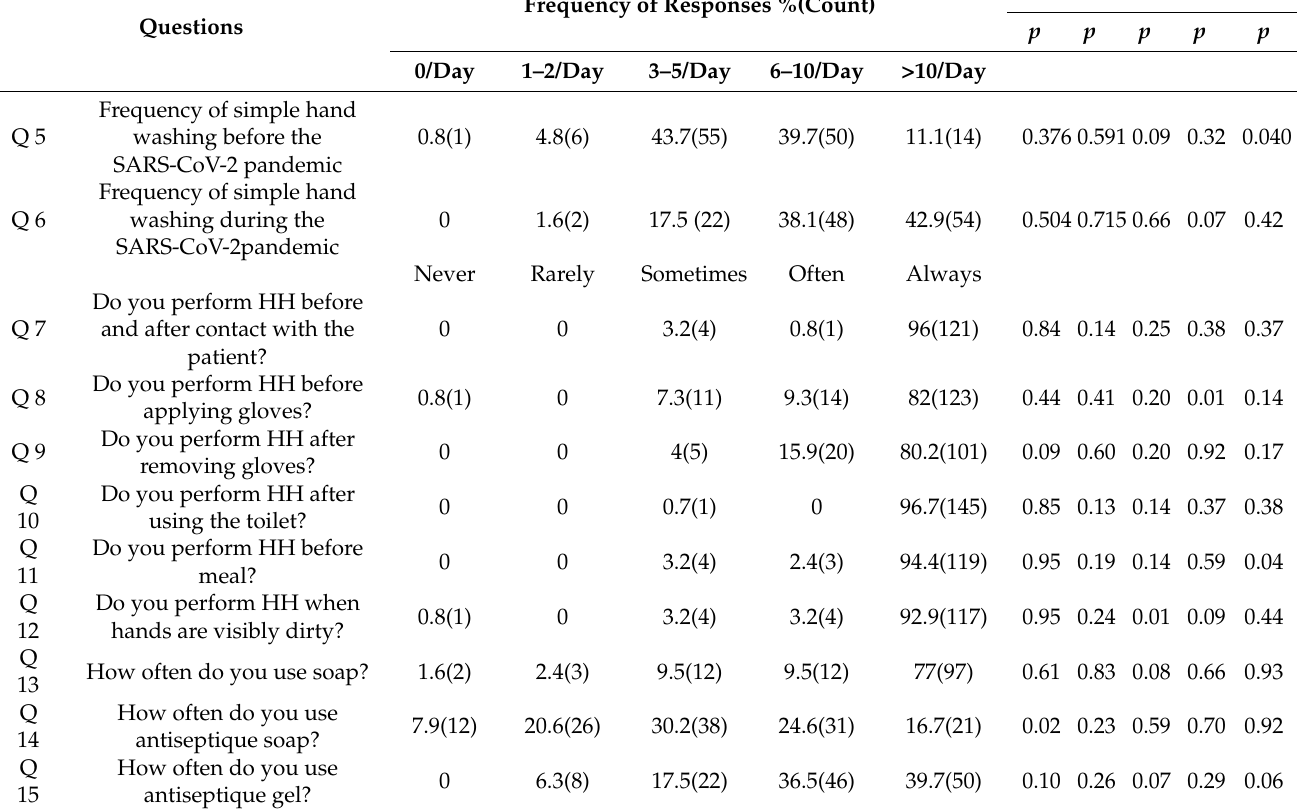
Table 2. Frequency of answers to questions concerning hand hygiene (HH) in relation to the patient and other situations and the use of HH products. Results of statistical significance tests comparing the frequency of HH in relation to the patient and the use of HH products by